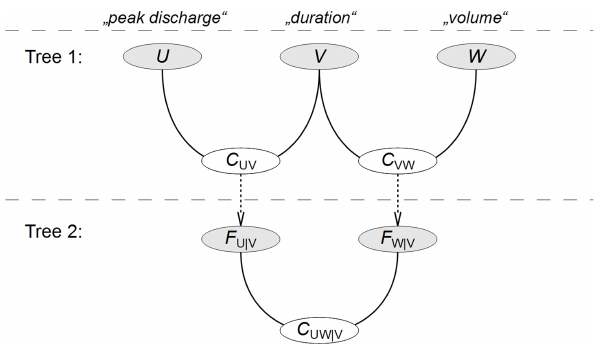
Fig. 1. Hierarchical nesting of bivariate copulas in the construction of a 3-D vine